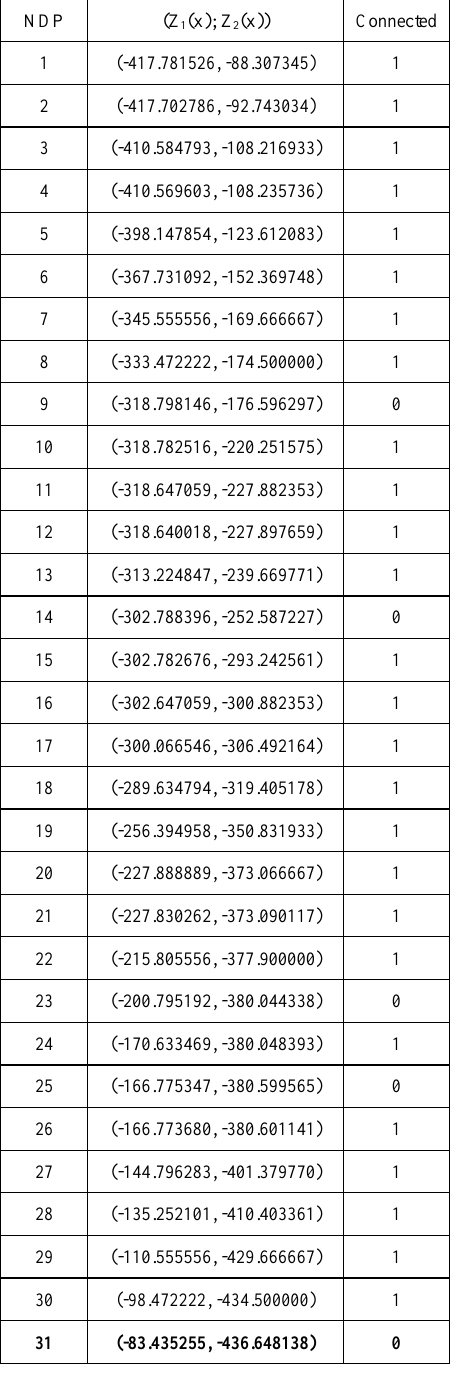
Table 5: Nondominated frontier points for first instance Boland et al. (2015) solved by